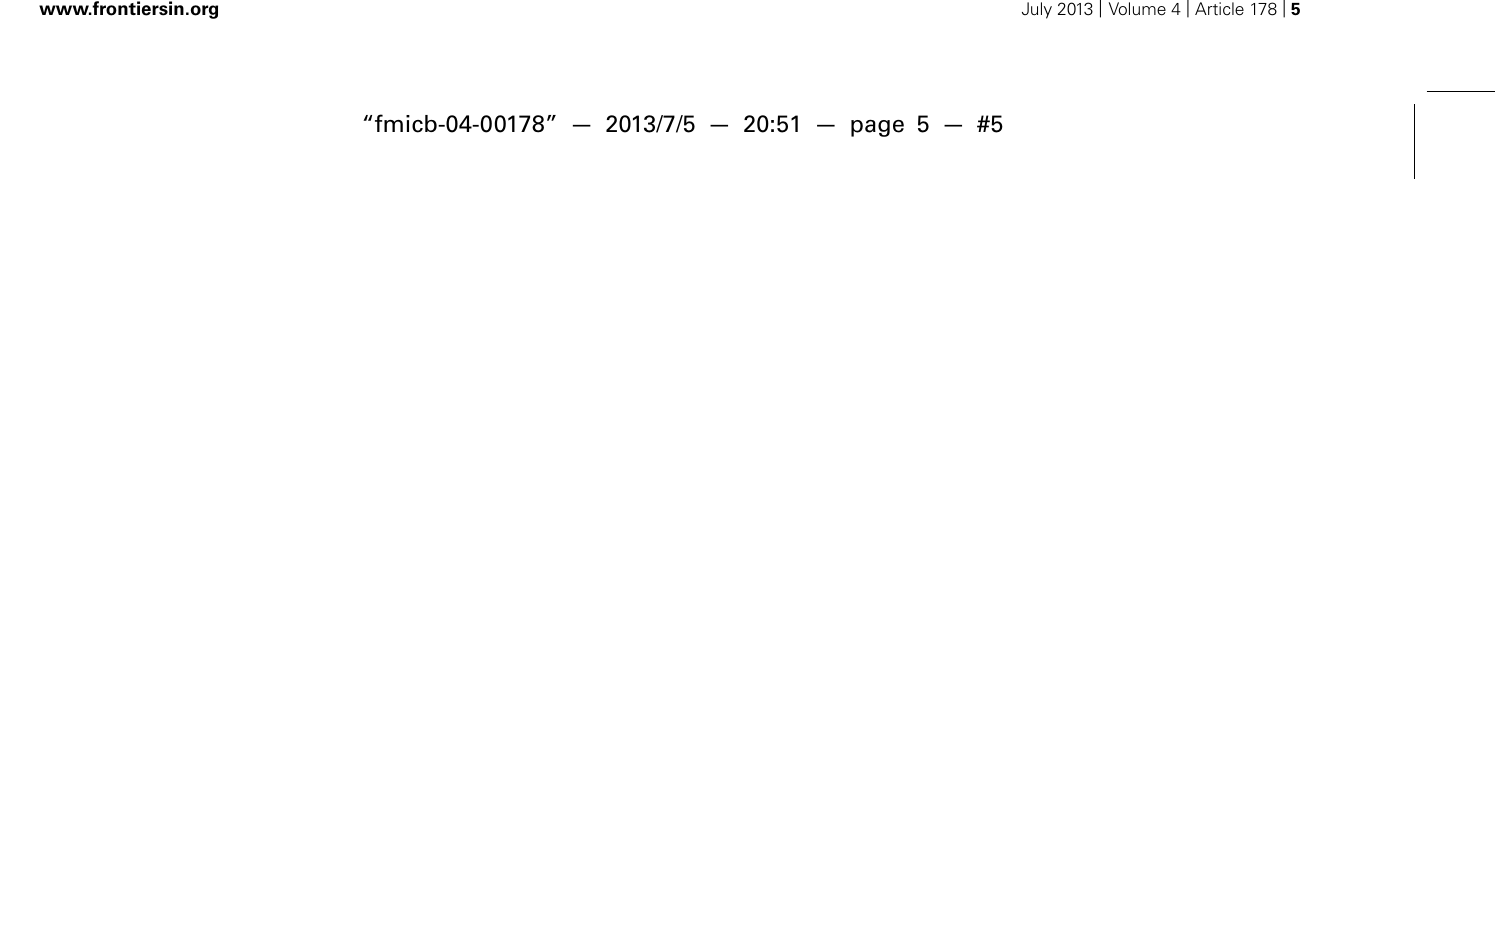
in vivo remains unclear. (B) Cis- infection: On the other hand, because DC express CD4 and chemokine receptors essential for HIV infection, DC are naturally susceptible to HIV infection. Although HIV replication is limited in DC, their strong antigen-presenting activity allows HIV to replicate more in antigen-specific CD4 + T cells tightly interacting with DC.This DC–T cell interaction is a genuine immunological synapse (IS).The precise molecular mechanism of HIV transmission from DC toT cells has yet to be clarified, but the cis- infection mode, is what most likely occurs in vivo